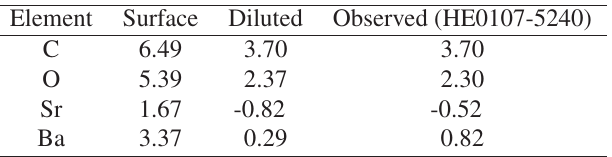
Figure 1. Evolution of the abundances of isotopes 56 Fe, 88 Sr, 138 Ba, and 208 Pb. Time is given in years and starts at the beginning of the PIE. These abundances were sampled at the position 0.4 M (cid:2) and is representative of the entire convective zone. Table 1.